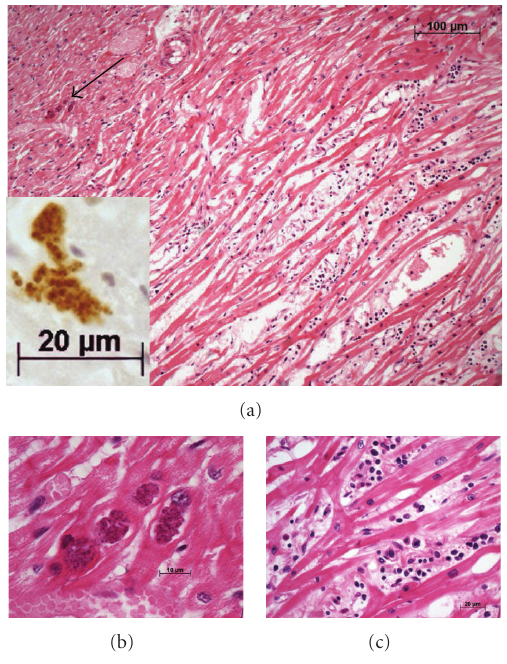
Figure 2: Photomicrographs of the myocardium in the necropsy. (a) In panoramic view, moderate to intense myocardial inflamma- tion with edema and mononuclear cells is visible. Large Toxoplasma pseudocysts, indicated by the arrow, existed in a region without inflammatory infiltrate. This region is amplified in image (b). The inset shows amplification of the pseudocyst, with antibody specific for T. gondii highlighting the round corpuscles, which is consistent with the tachyzoites form of T. gondii . (b) The tachyzoites are still closed and hidden intracellularly. (c) A high magnification of the myocardium in an area of myocarditis. The infiltrate was composed of lymphocytes, plasma cells and histiocytes ((a), (b) and (c) Hematoxylin and eosin stain with objective × 10, × 100 oil and × 40, respectively; objective × 40 with digital zoom at the